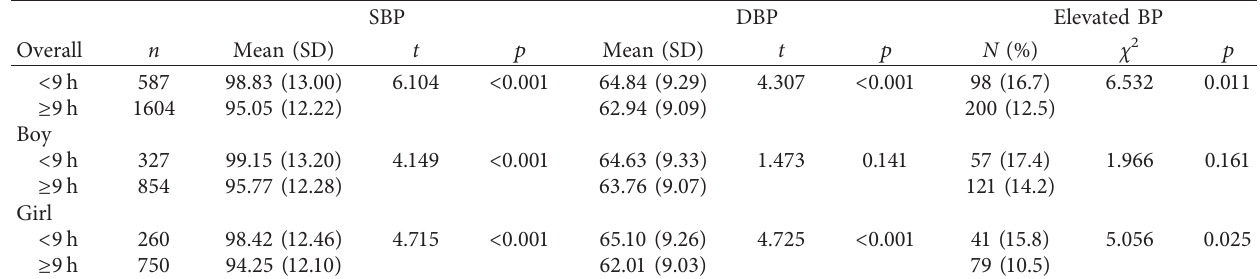
Table 3: The distribution of BP based on sleep duration, converging all survey times. SBP DBP Elevated